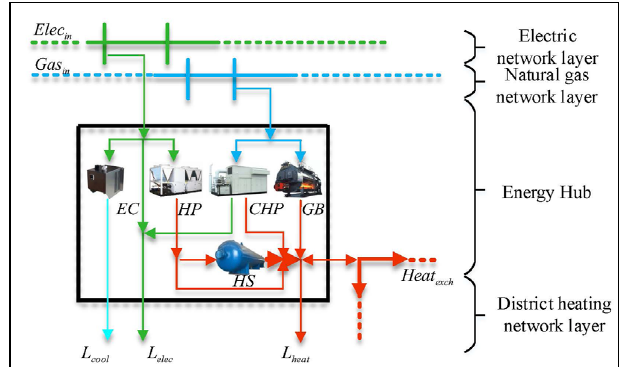
FIGURE 1 | Structure diagram of ECU.